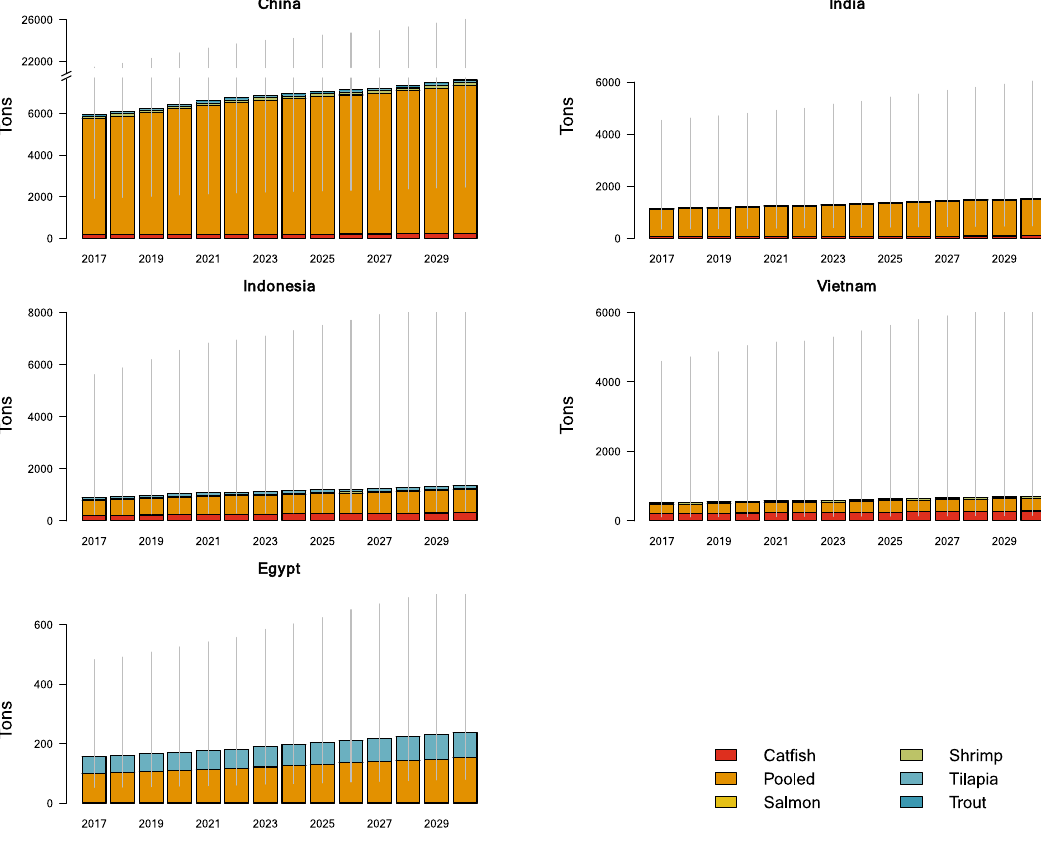
Figure 2. Projected antimicrobial use (tons) in aquaculture by species by 2030 in the five highest-consuming countries. The China panel y-axis is broken at 8000 and resumes at 20,000 tons. Error bars represent the 95% uncertainty intervals for the annual total